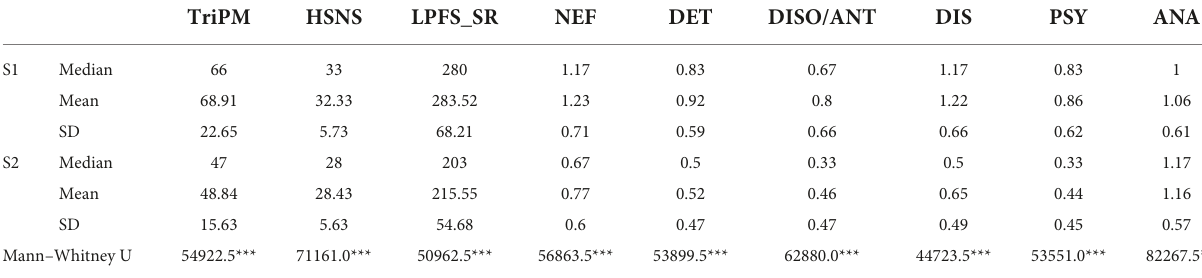
TABLE 2 Discrimination capacity between